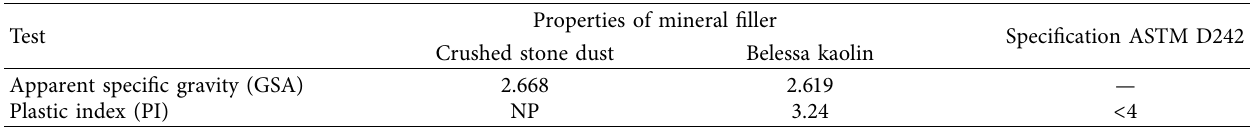
Table 4: Physical properties of CSD and Belessa kaolin